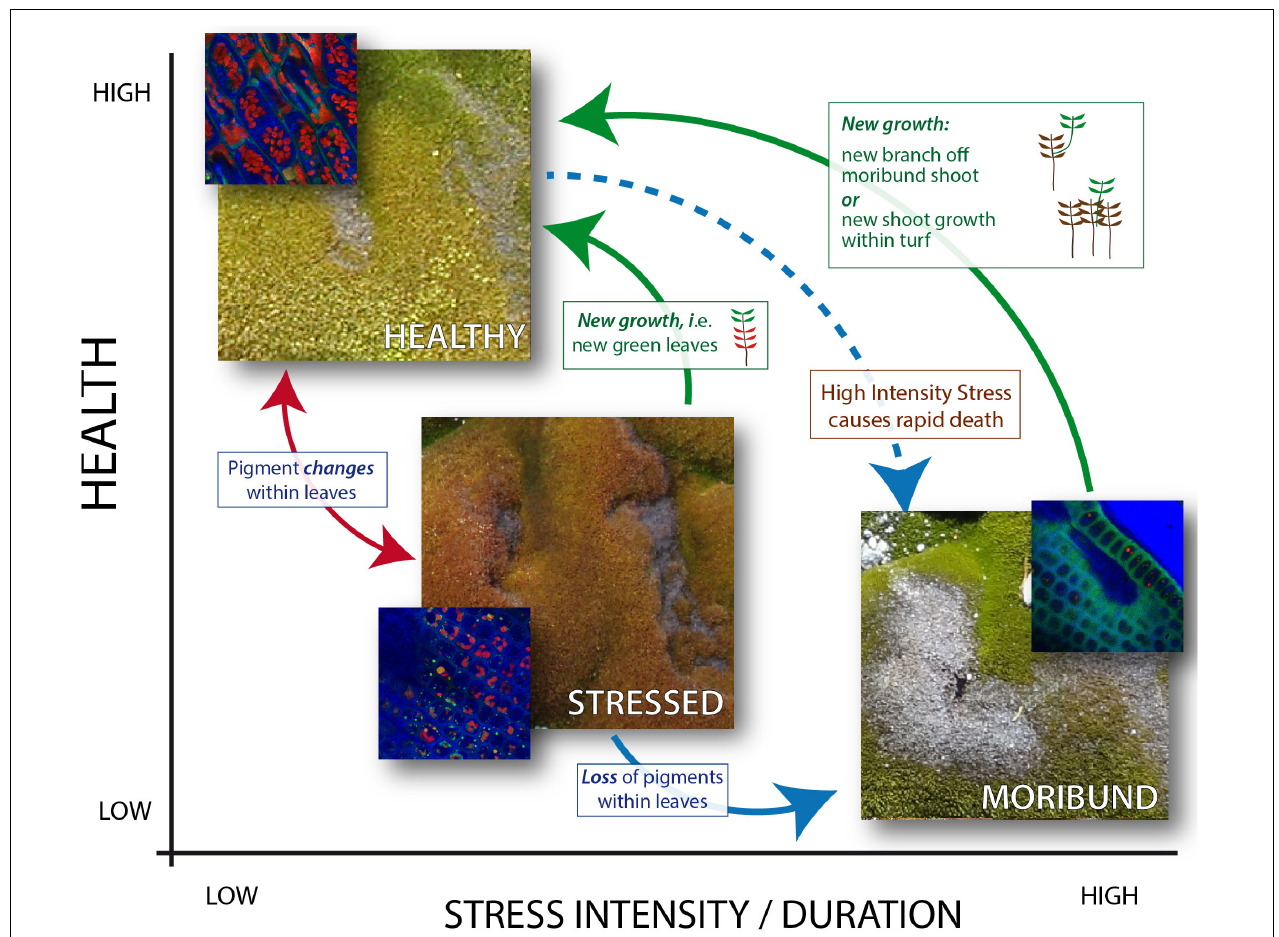
FIGURE 8 | Diagrammatic representation of East Antarctic moss health state relationships. The intensity or duration of stress ( x axis) impacts the health state ( y axis). Solid arrows indicate observed heath state changes (2003–2014) of monitoring moss health in the Windmill Islands, with red and blue arrows indicating pigment changes within the cells of an individual plant, while green arrows indicate growth of new healthy leaves/plants at a turf level. Note that the three images show the same area of moss in different years, and that the moribund moss is the gray moss in the lower right image. Inset images (blue) depict confocal microscope images of cells at each stage of moss health, with bright red chloroplasts obvious in healthy moss but less clear in stressed moss and absent in moribund moss. Extreme high intensity stress is thought to cause immediate state change from healthy to moribund (dashed blue arrow), however, evidence for this is only